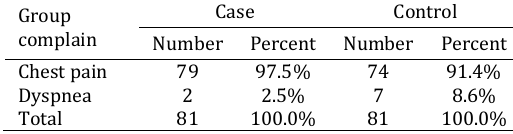
Table 3. Symptoms difference between two groups Group